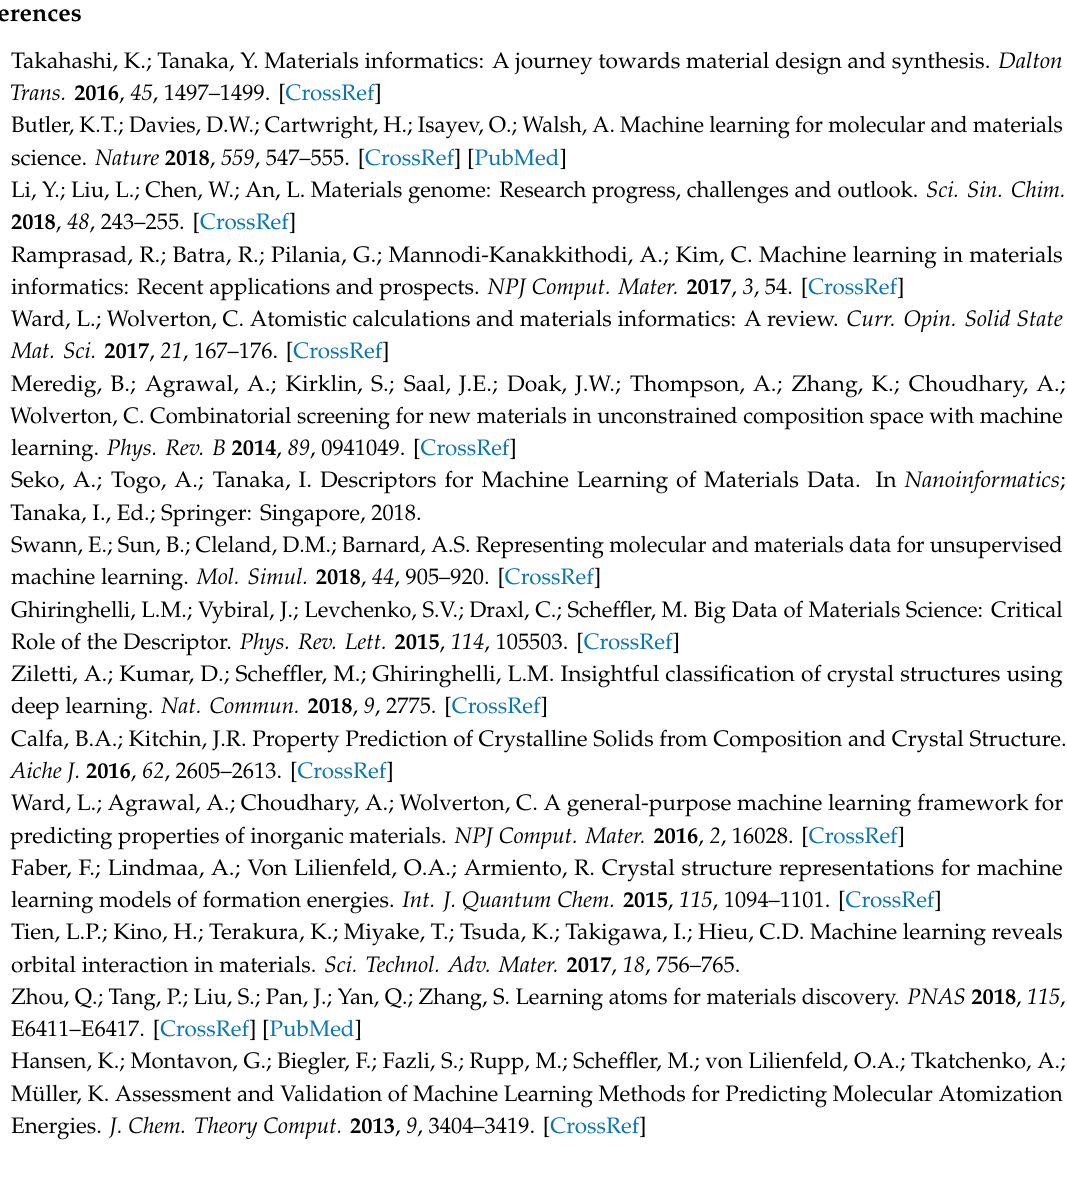
Table S1: Electron configuration of atoms used in data set, Table S2: Architectures of CNN for OFM descriptor, Table S3: Architectures of CNN for Magpie descriptor, Figure S1: Scatter plots and error metrics for CNN and several regression